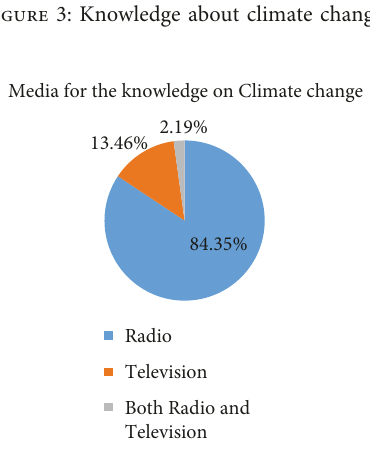
Figure 4: Sources of knowledge about climate change.